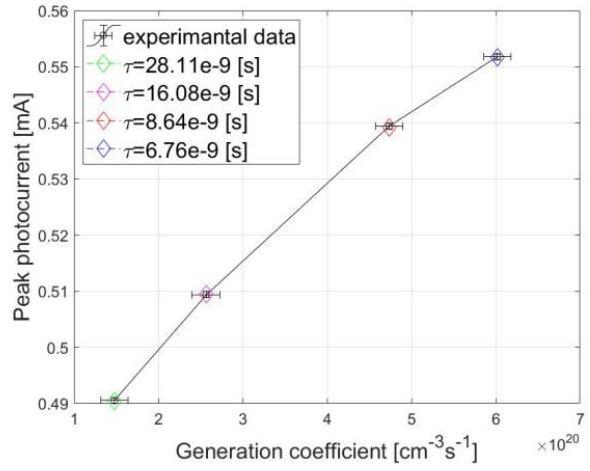
Figure 3. Illustration of the peak photocurrent values depending on the value of the coefficient of generation of electron-hole pairs G . The simulation values were assigned to the experimental values depending on the carrier lifetime coefficient τ . Simulations carried out for a temperature of 300 K.